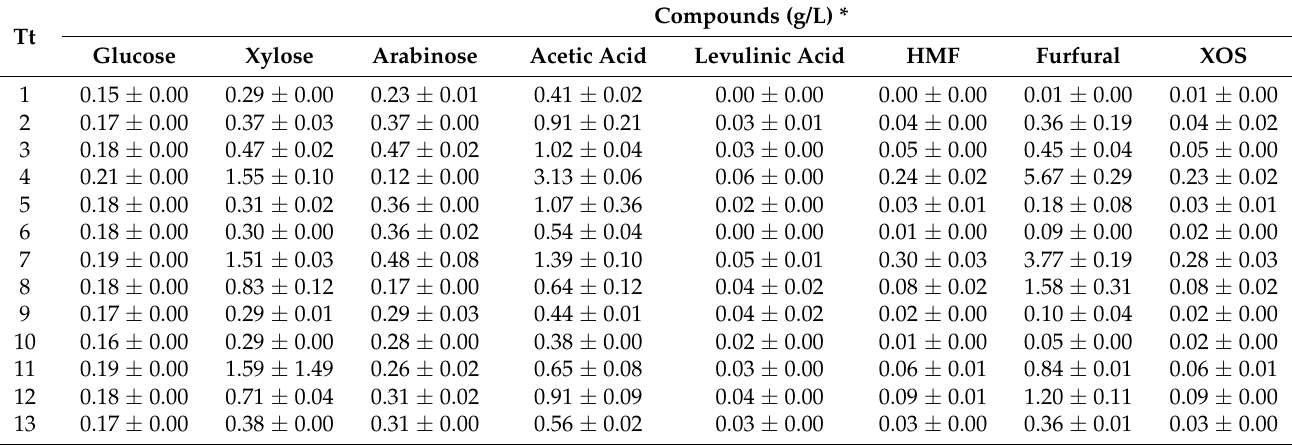
Table 4. Liquid phase composition after hydrothermal